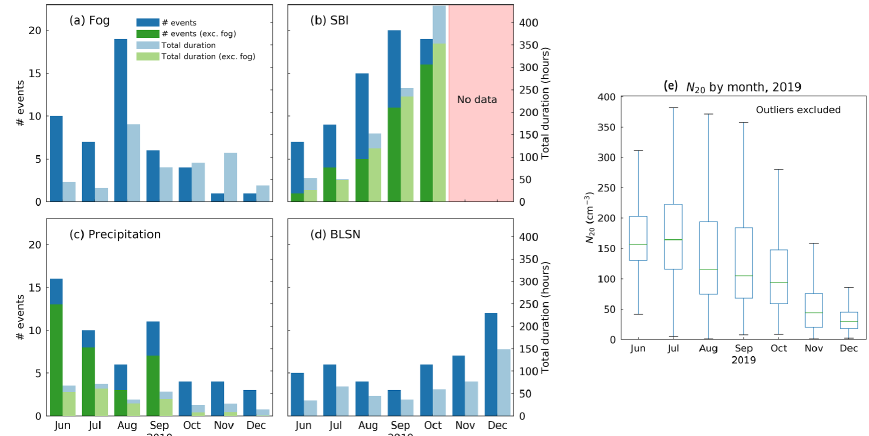
Figure 5. Frequency and duration of (a) fog events, (b) surface-based temperature inversion events, (c) precipitation events, and (d) blowing snow events, detected between June and December 2019 using the methodology described in Sects. 2.2–2.4. Blue bars include all events, and green bars show the change in distribution for SBI and precipitation events after the removal of events containing fog. (e) The distribution of N 20 for the same months, excluding